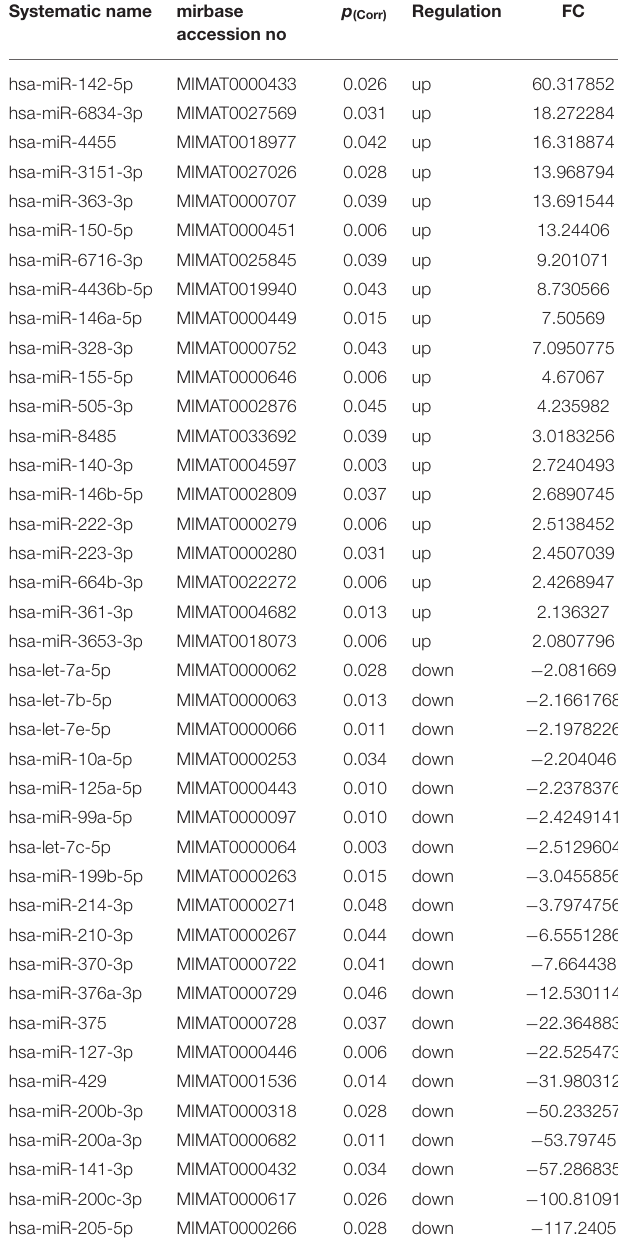
TABLE 2 | Differentially expressed miRNAs comparing LN and matched primary breast cancer